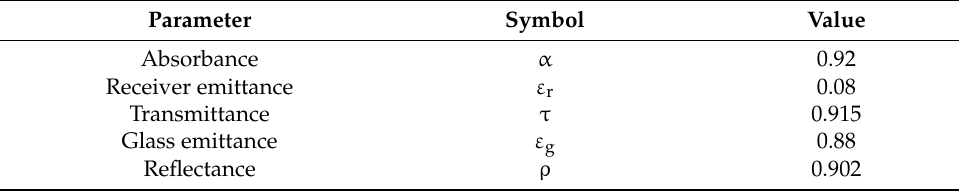
Table 3. Optical and thermal properties [3,25].